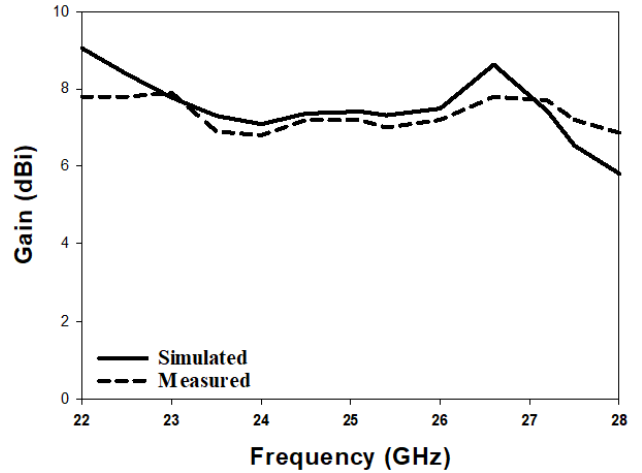
Figure 11. Simulated and measured axial ratio of a circularly polarised hemispherical DRA with added substrate between the DRA and feed.